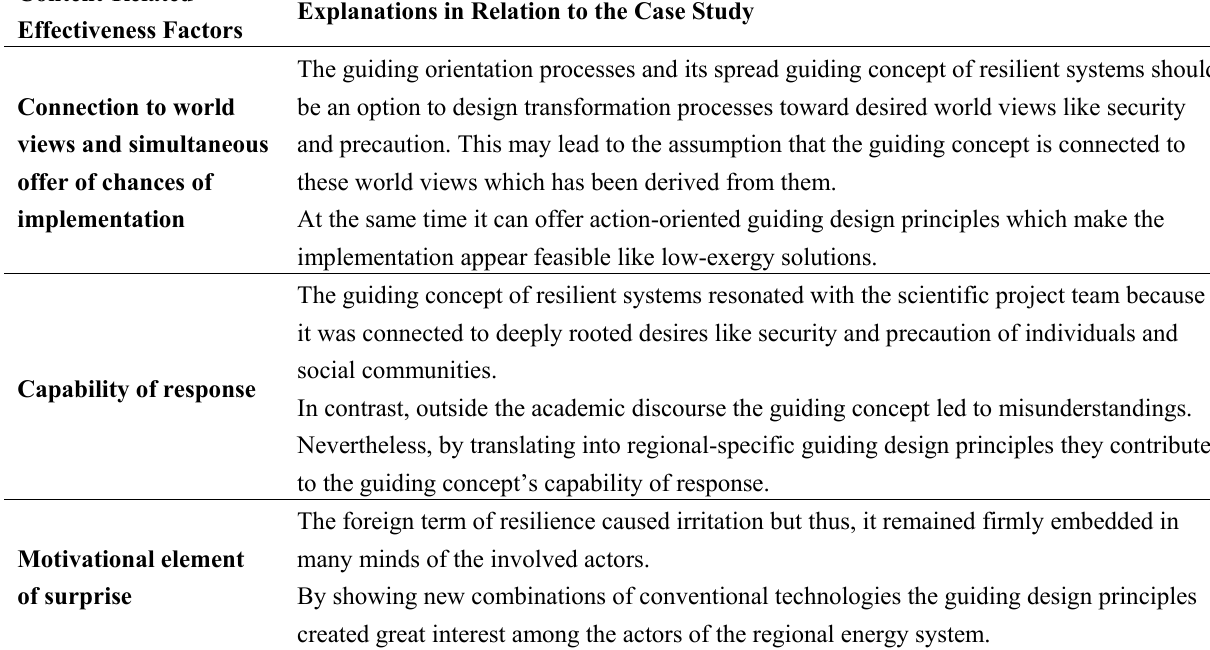
Table 2. Content-related and process-related effectiveness factors for the guiding orientation process.